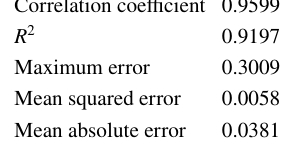
Table 9 Correlation coefficient, R 2 , maximum error, mean squared error and mean absolute error of calibration curve